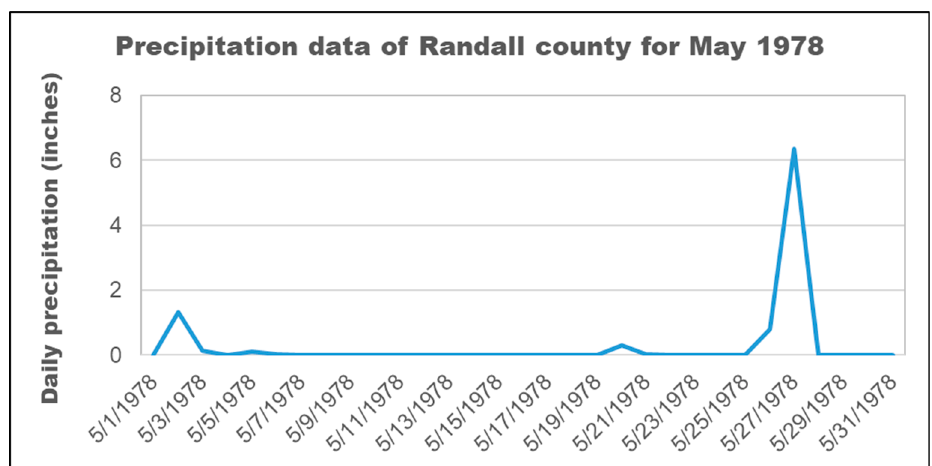
Figure 4. Storm event of May 1978 in Randall County. Water 2019 , 11 , 1920